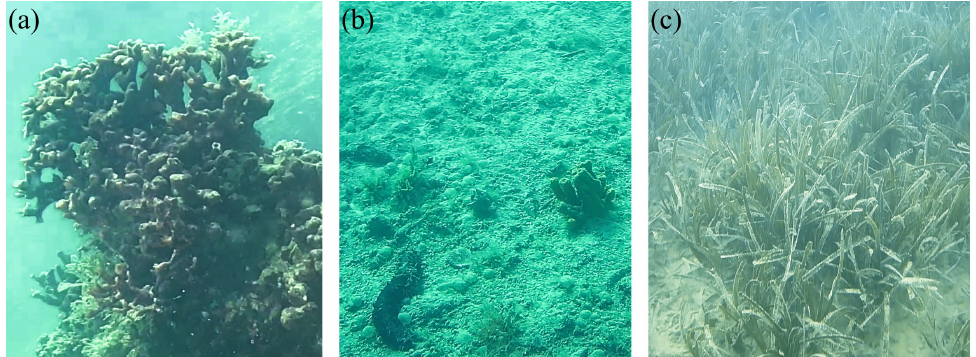
Figure 13. Some marine species identified in images acquired by PilotCAM: ( a ) Schizoporella errata . ( b ) Axinella sp., Holothuria sp., eggs masses of Polychaeta . ( c ) Posidonia oceanica .